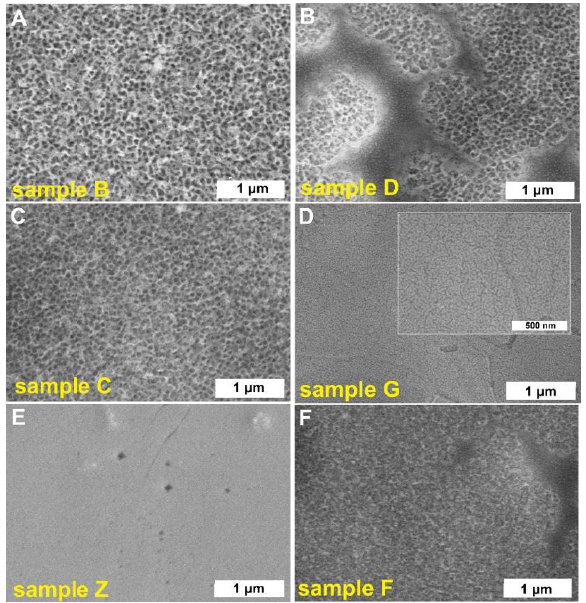
Figure 1. SEM images of anodic WO 3 obtained in different anodizing conditions: 1 M(NH 4 ) 2 SO 4 + 0.075 M NH 4 F at 50 V for 4 h – sample B ( A ), 1 M Na 2 SO 4 + 0.19 M NH 4 F at 40 V for 15 min – sample D ( B ), 1 M Na 2 SO 4 + 0.12 M NaF at 40 V for 2 h – sample C ( C ), 0.27 M NH 4 F (in 2.2 wt.% H 2 O in ethylene glycol) at 10 V for 1 h – sample G ( D ), 1.8 M NaOH at 35 V for 45 s – sample Z ( E ), and 0.15 M